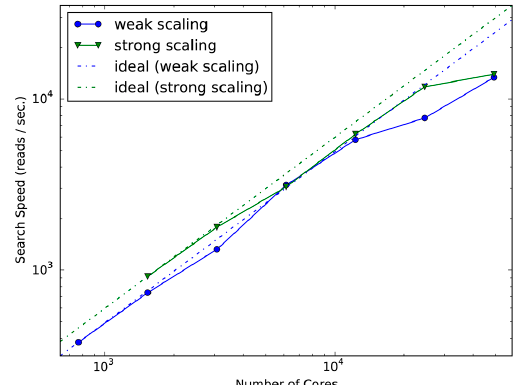
Figure 2. Scalability of GHOST-MP on the K computer. Strong scaling and weak scaling were measured using 768–49,152 CPU cores. The similarity search of the sequencing data with the KEGG GENES amino acid sequence database on the K computer took 183 h (898,231 core hours, which is the product of the number of CPU cores used and the elapsed time). Searches of all sequencing data (except SRS055118) were completed within 2 h (Table S1). The combination of a sophisticated search